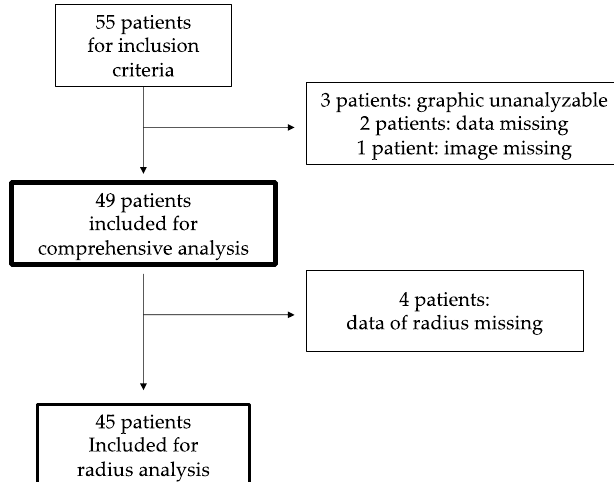
Figure 1. Inclusion and exclusion criteria.